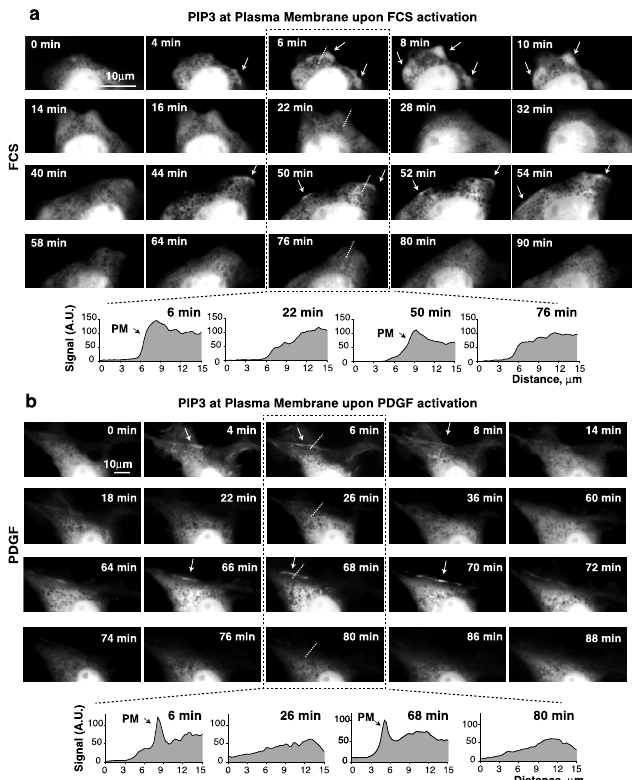
Figure 2. PDGF and serum induce PIP 3 recruitment at the plasma membrane. ( a , b ) NIH3T3 cells were transfected with GFP-Btk-PH (48 h), then incubated in serum-free medium (2 h) and activated with FCS (15%) ( a ) or PDGF (50 ng/mL) ( b ). An image was taken prior to activation (t = 0) and then every 2 min for 90 min after GF addition. Representative frames from the video (time after GF addition indicated). The graphs at the bottom ( a , b ) show the Btk-PH signal (in arbitrary units) on the virtual line indicated in the central images.